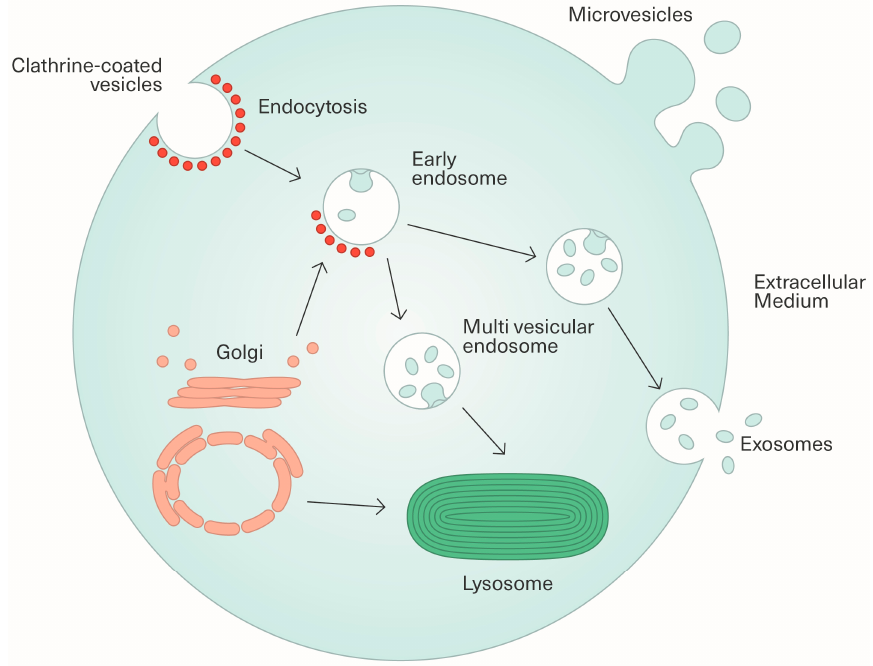
Figure 1. Exosome and microvesicle biogenesis. Exosomes originate from the inward budding of endosomes to form multivesicular endosomes (MVEs). MVEs then fuse with the cell surface membrane to release exosomes into the extracellular medium. Some MVEs fuse with lysosomes. Microvesicles are produced by direct budding from the plasma membrane.